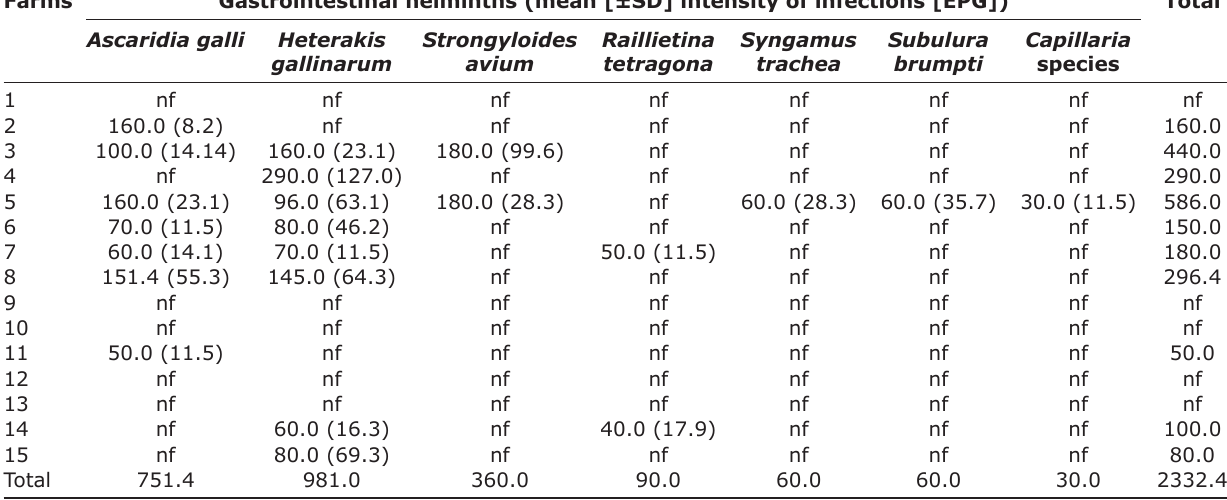
Table-3: The mean (±SD) intensity of gastrointestinal helminths (EPG of feces) of intensively managed poultry in individual farms in Kwara Central, Kwara State.